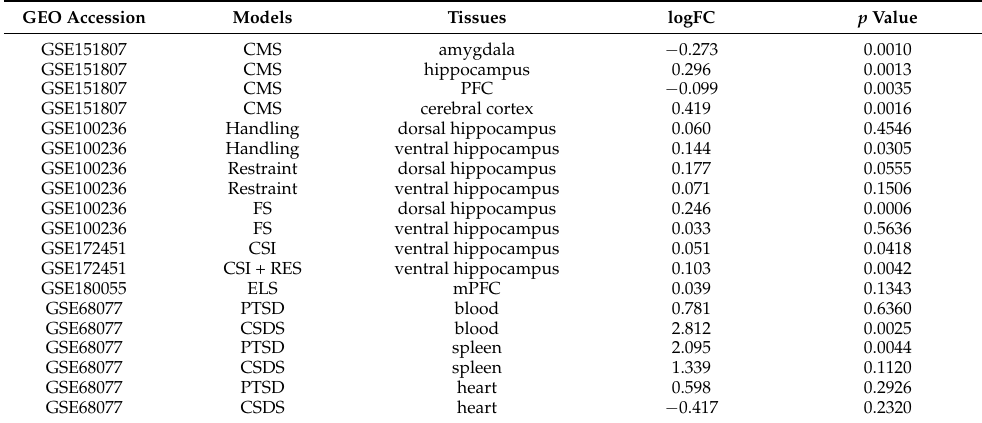
Table 3. The expression of TF in different brain regions and tissues in various stressed animal models from GEO database.